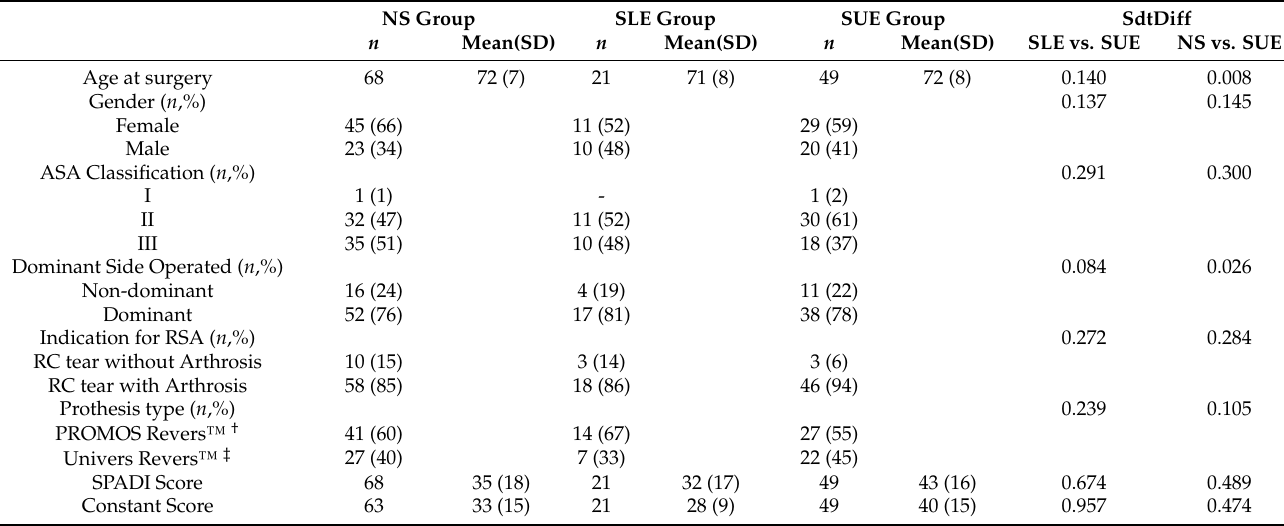
Table 2. Baseline patient demographics and shoulder